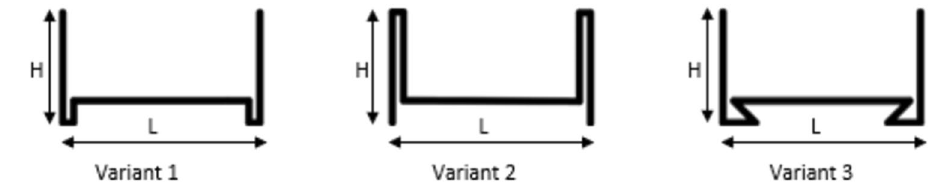
Fig. 16 Tested corrugated cardboard trays for